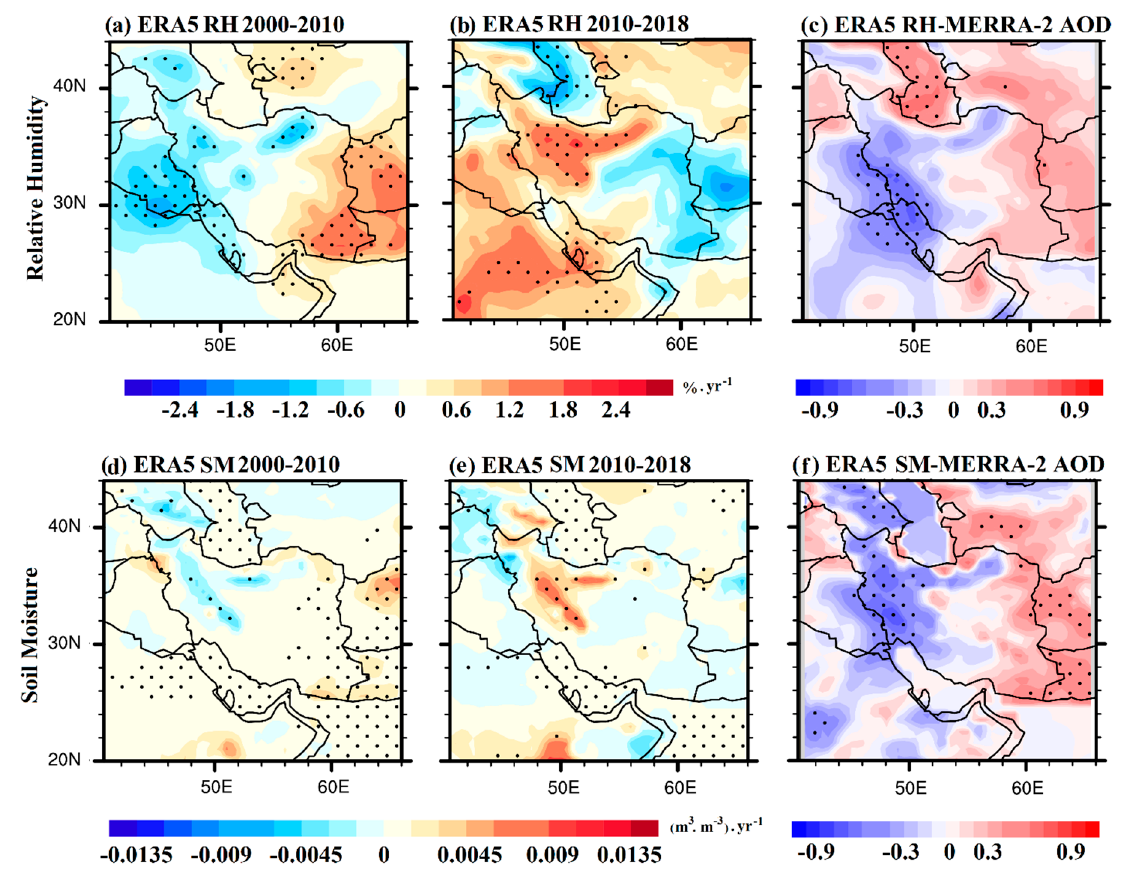
Figure 10. Spatial distributions of the winter (DJF) linear trends in the ERA5-derived relative humidity (RH) and soil moisture (SM) during the periods 2000–2010 ( a , d ) and 2010–2018 ( b , e ) and their respective correlations with the MERRA-2 AODs ( c , f ) calculated during the period 2000–2018. The black dots denote the statistical significance of the trends and correlations at a 95% confidence level ( p < 0.05).